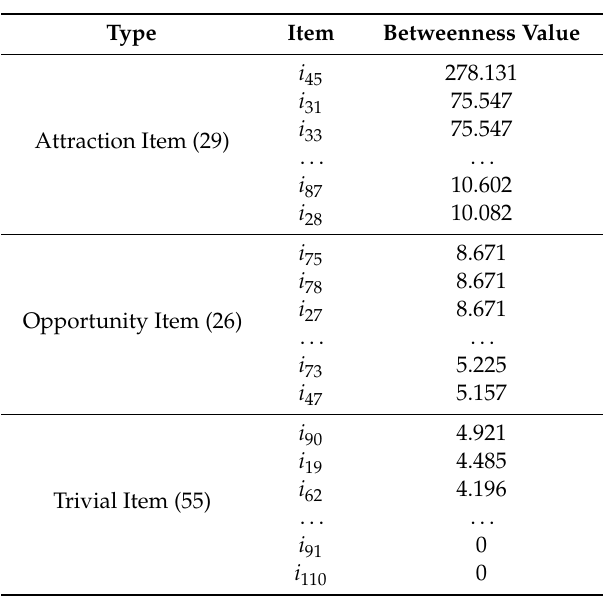
Table 3. Item classification example.